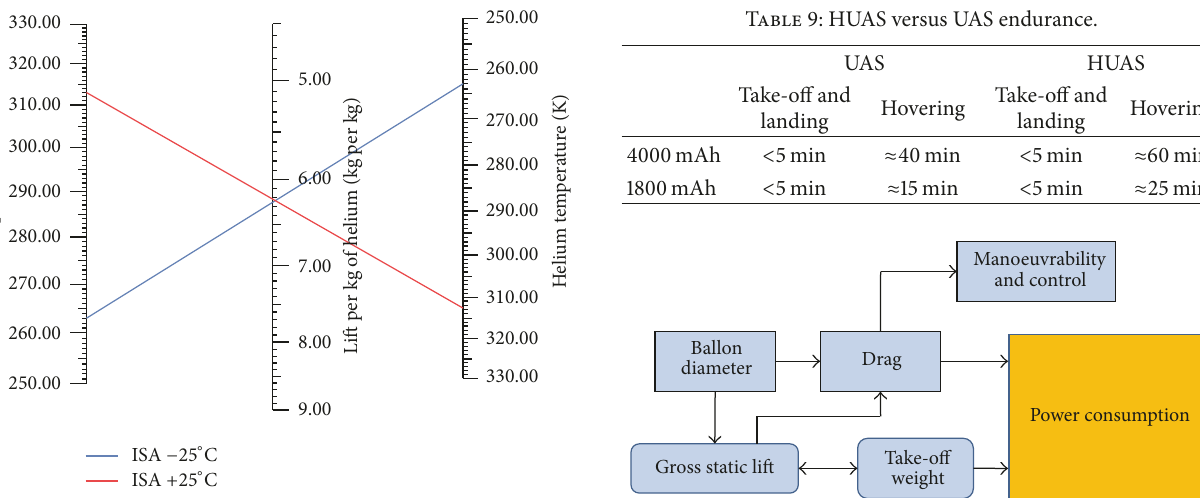
Figure 11: Expected static lift per kg of He in ISA − 25 ∘ C and ISA +25 ∘ C. The value (almost the same for both cases) has been found to be about 6.22 kg per kg of He.